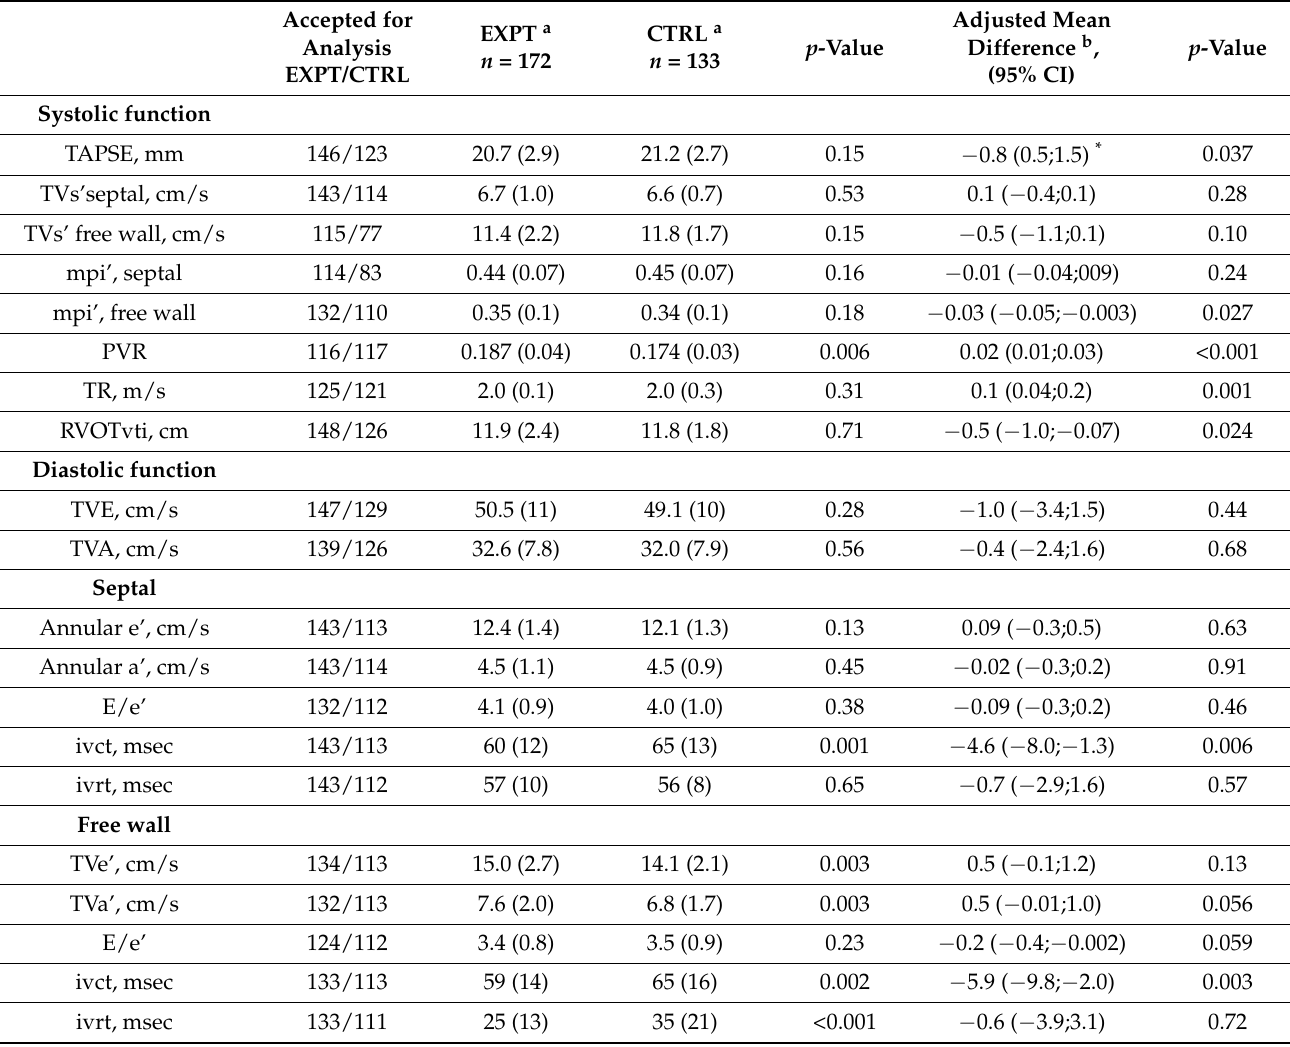
Table 3. Right heart systolic and diastolic function in 6.5-year-old children born extremely preterm (EXPT) and in controls born at term